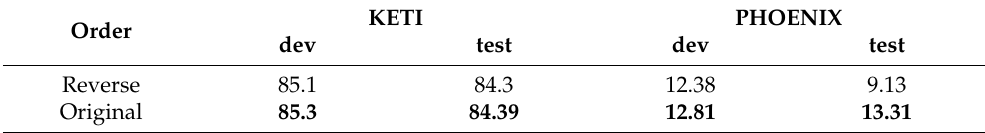
Table 7. BLEU-4 score in order of input values.